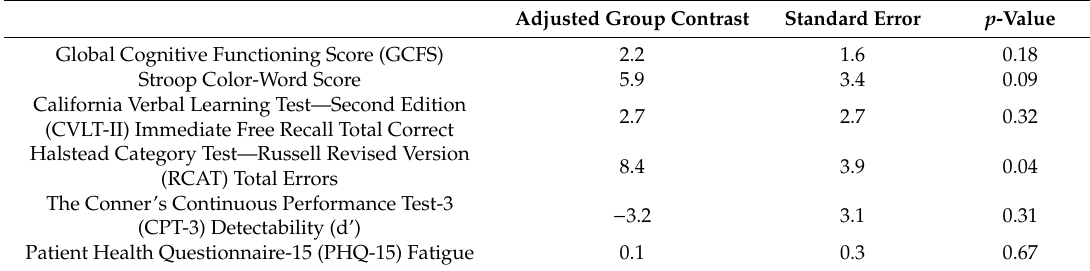
Table 4. Group contrasts in baseline-adjusted endpoint by outcome. Placebo group is the reference; positive values reflect greater improvement in cognitive functioning in the Concord grape juice